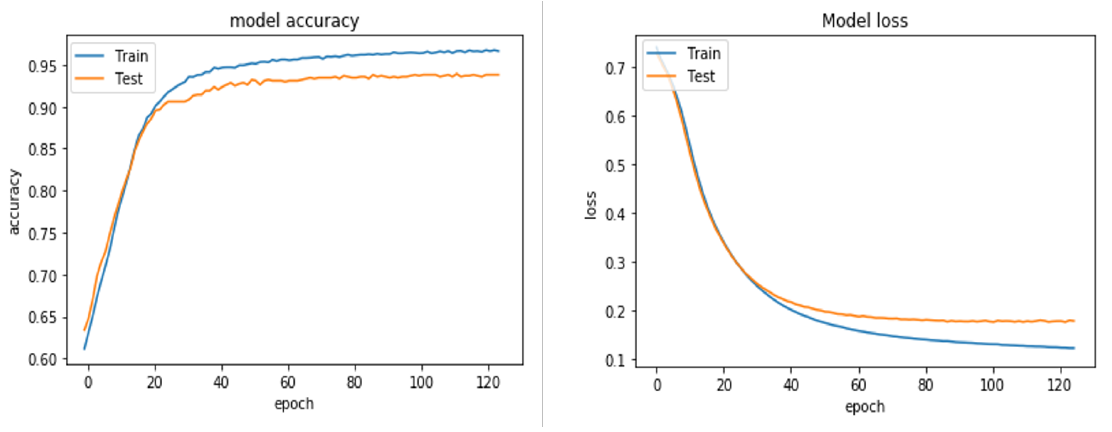
Figure 6. SNN Model Accuracy and